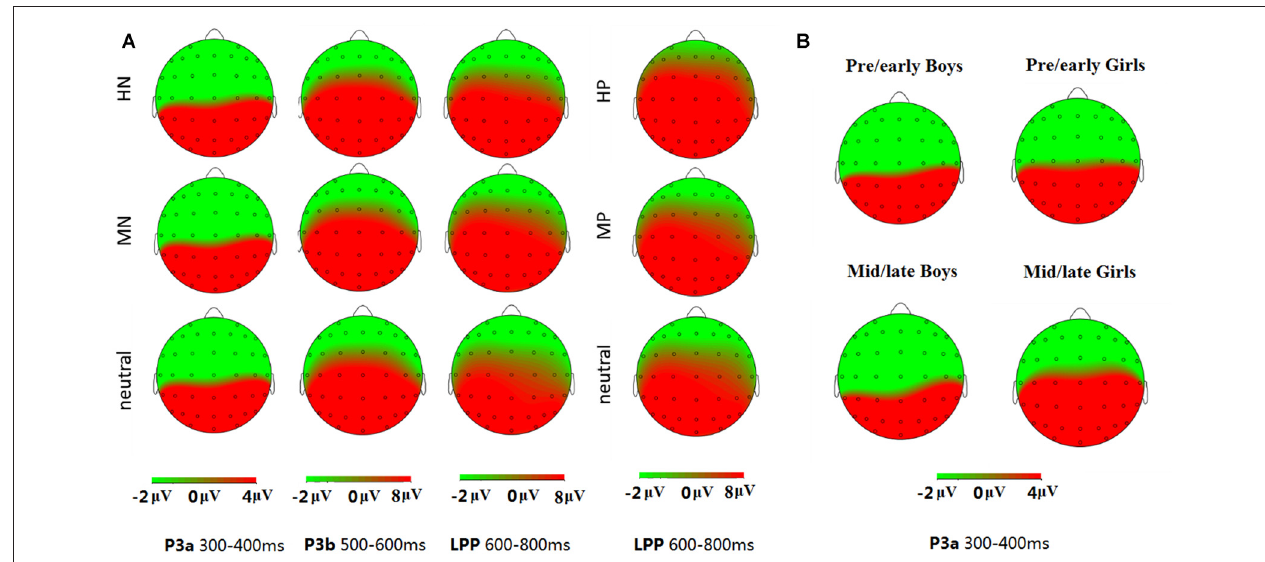
FIGURE 3 | Topographical maps of the voltage amplitudes elicited by different stimulus categories in P3a (300–400 ms), P3b (500–600 ms) and late positive potential (LPP; 600–800 ms) time interval (A) ; and topographical maps of the voltage amplitudes for the negative block in the P3a (300–400 ms) time interval for each group (B) .